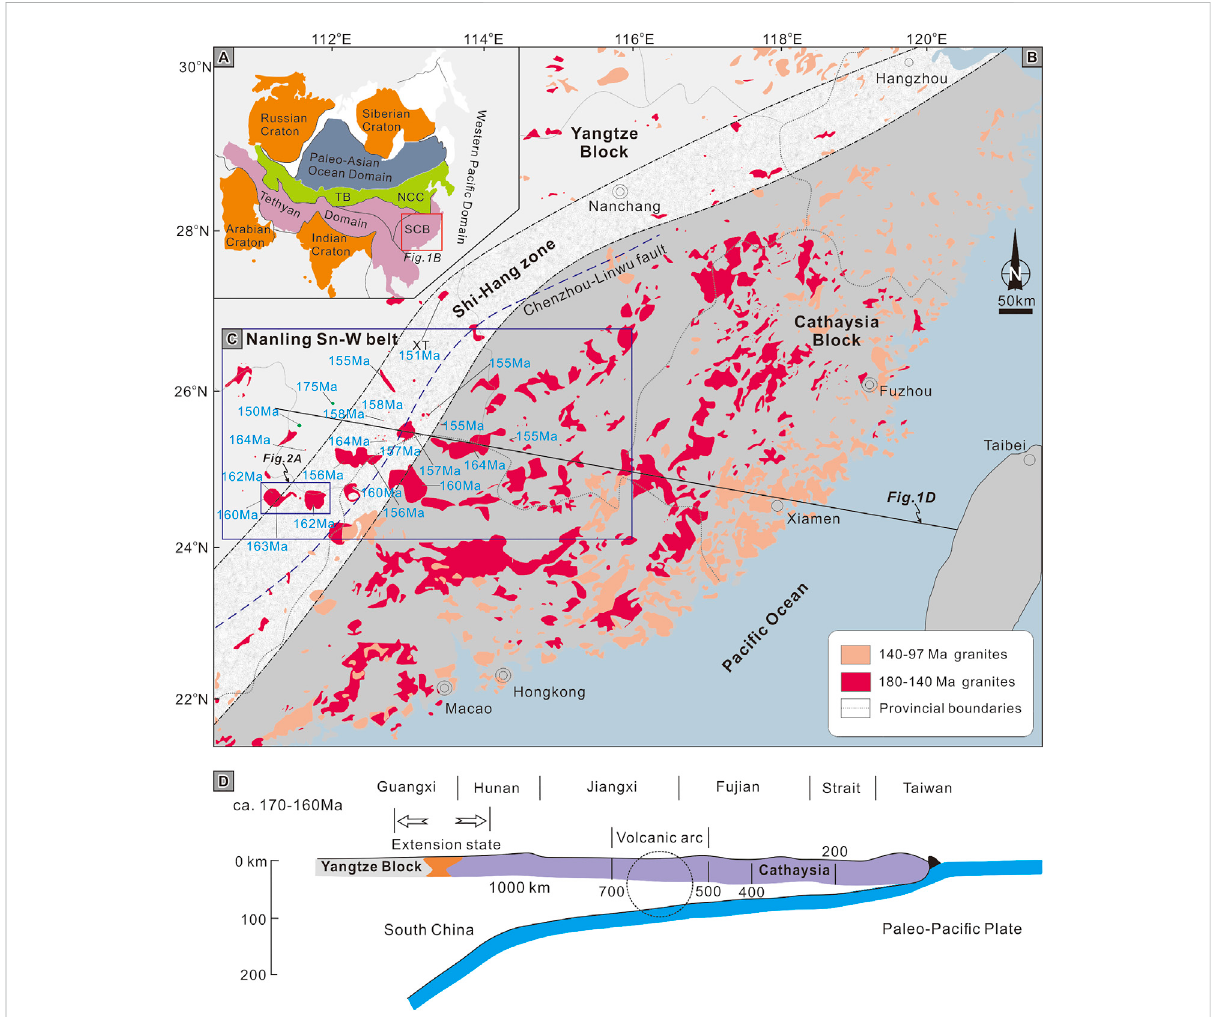
FIGURE 1 (A) TectonicmapofAsiashowingcontinentalblocksandboundingsutures(modi fi edafterCawoodetal.,2018). (B) DistributionoftheJurassic- Early Cretaceous intrusions in South China (modi fi ed after Xiao et al., 2019 and references therein). (C) Sketch map of the Nanling Sn-W belt (Mao et al., 2021a). (D) Simpli fi ed map showing the Middle-Late Jurassic Paleo-Paci fi c subduction in southeast China (Zhou and Li,